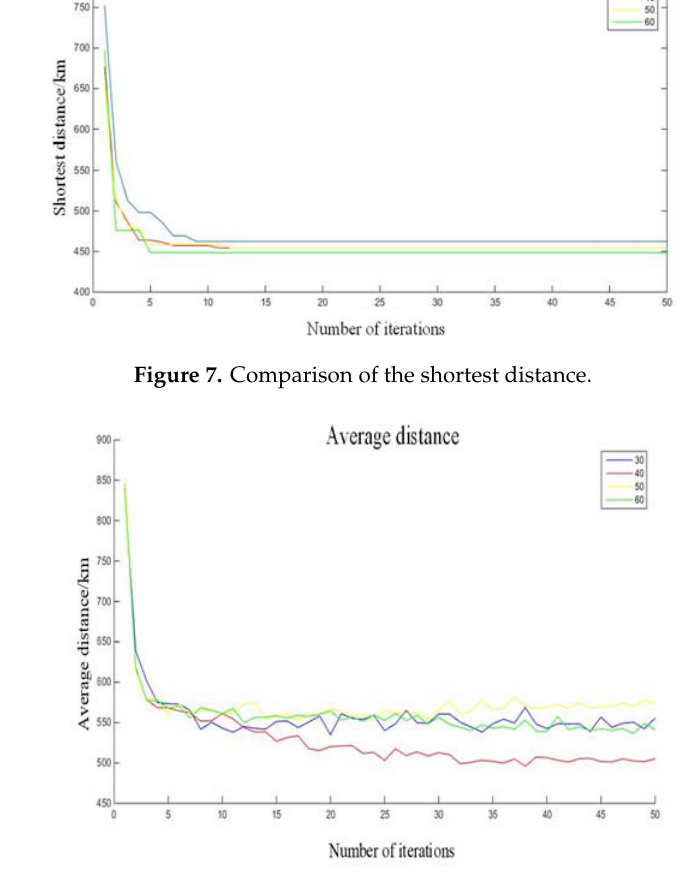
Figure 8. Comparison of average distance.